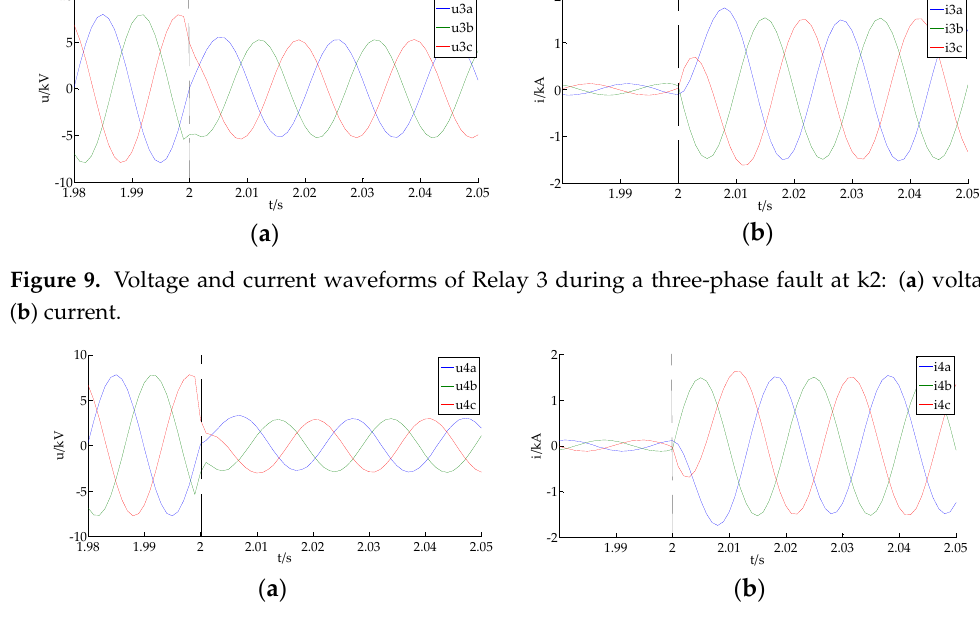
Figure 10. Voltage and current waveforms of Relay 4 during a three-phase fault at k2: ( a ) voltage; ( b ) current. The PSFC’s impedance angles at Relays 3 and 4 are − 114° (sensitive area) and 65.85° (negative direction), respectively. Therefore, Relay 3 identifies that a positive fault has occurred, and Relay 4 identifies that a negative fault has occurred.